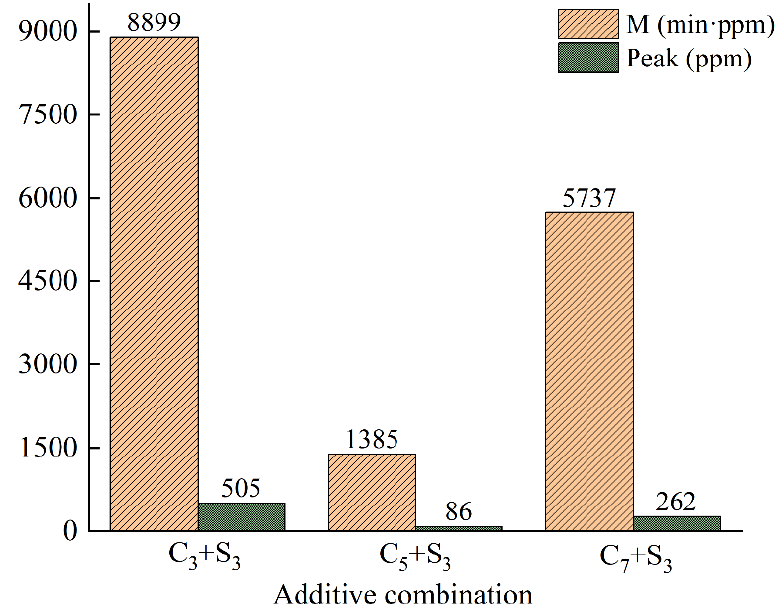
Figure 7. VOCs emission M and peak value P of environment-friendly modified asphalt under different activated carbon content.